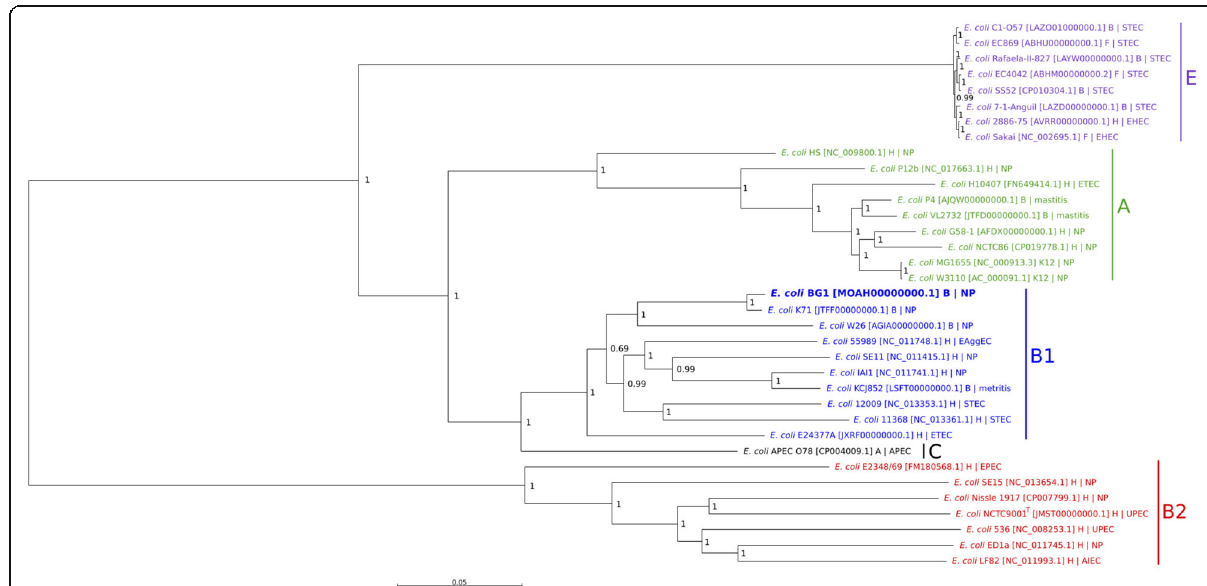
Fig. 2 Phylogenetic tree highlighting the position of E. coli BG1 relative to other E. coli strains. The whole genome SNP based phylogeny was established with CSI phylogeny 1.4 [28] using the genome of K71 as a reference and standard input parameters. The tree was midpoint rooted and plotted using Seaview (version 4.6.1) [56]. Each strain is identified as H (Human), B (Bovine), A (Avian), F (Food) or K12 (Laboratory strain), and its clinical or non-pathogenic (NP) characteristic is specified.